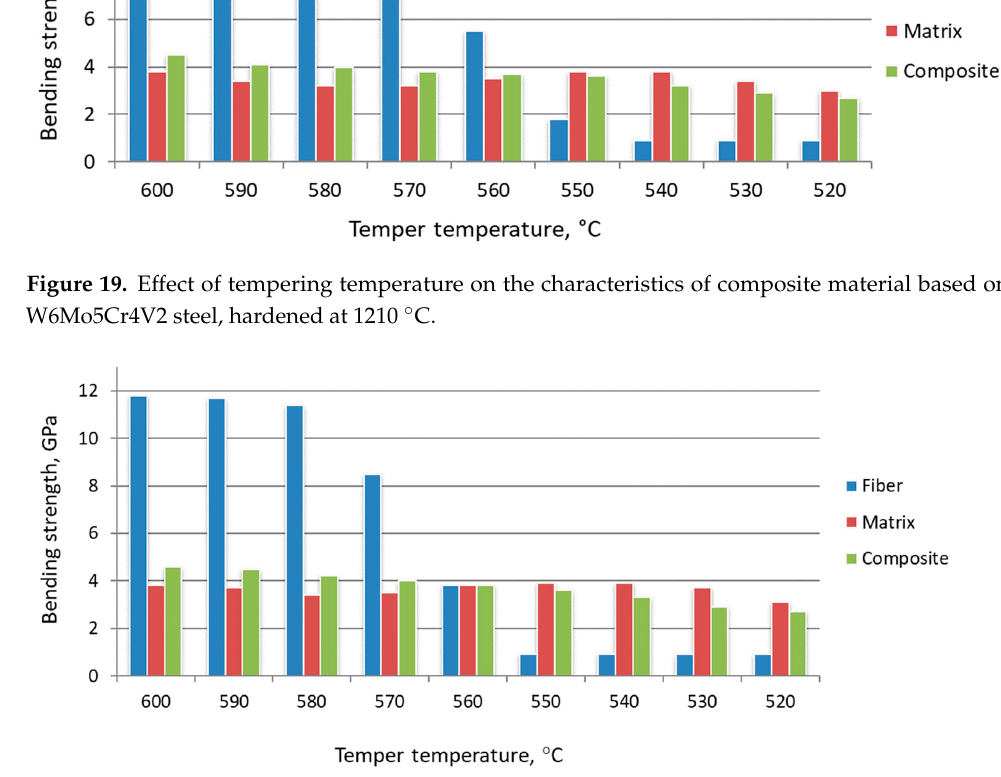
Figure 20. Effect of tempering temperature on the characteristics of composite material based on W6Mo5Cr4V2 steel, hardened at 1220 ◦ W6Mo5Cr4V2 steel, hardened at 1220 °C.